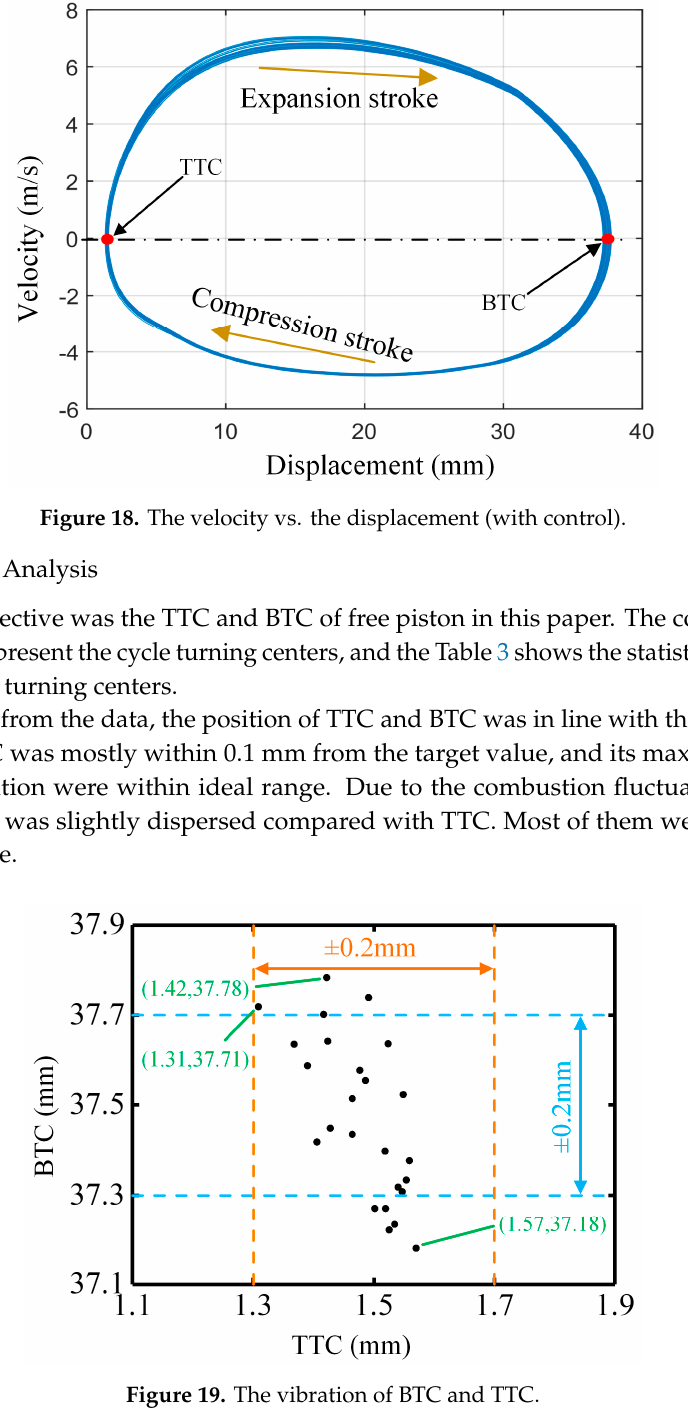
Figure 17. The velocity vs. the displacement (without control).